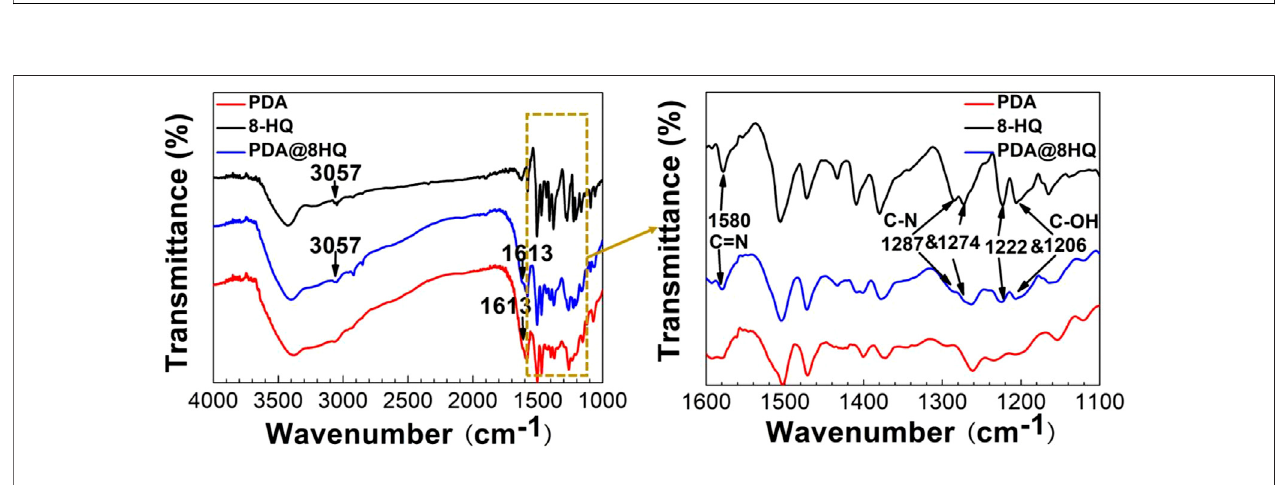
FIGURE 2 | ATR-FTIR spectra of different copper